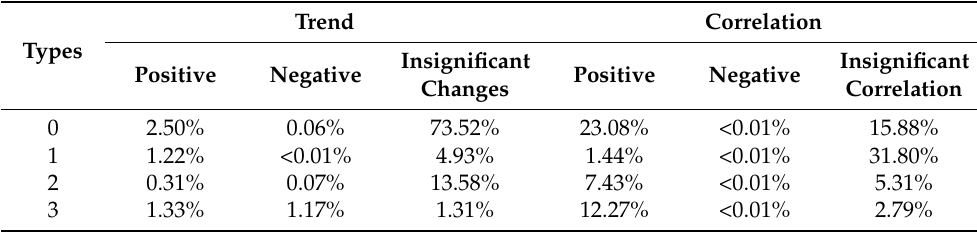
Table 4. Comparison statistics of the agreement metrics of interannual variation difference, derived from three products.